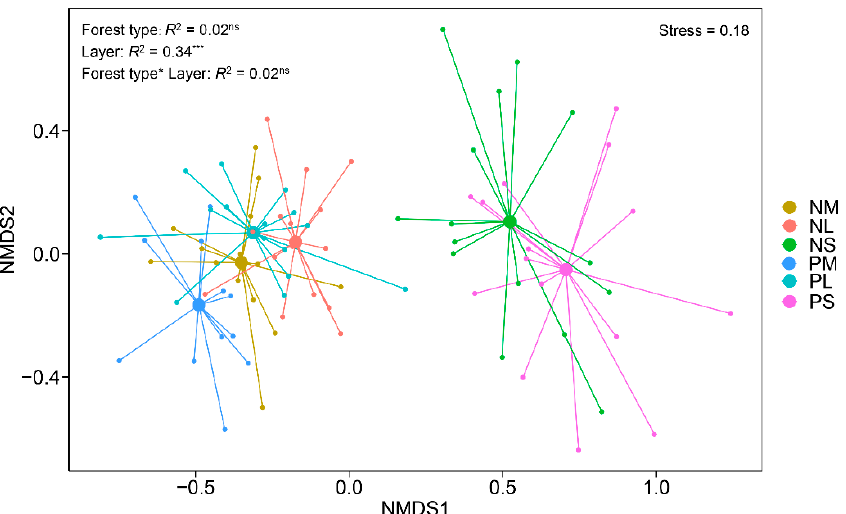
Figure 2. Non-metric multi-dimensional scaling (NMDS) based on Bray – Curtis similarity for the nematode community composition in subalpine spruce plantations and natural forests. PM: planta- tion moss layer; PL: plantation litter layer; PS: plantation soil layer; NM: natural forest moss layer; NL: natural forest litter layer; NS: natural forest soil layer. *: interaction of forest type and layer. ***: p < 0.001; ns: p > 0.05.